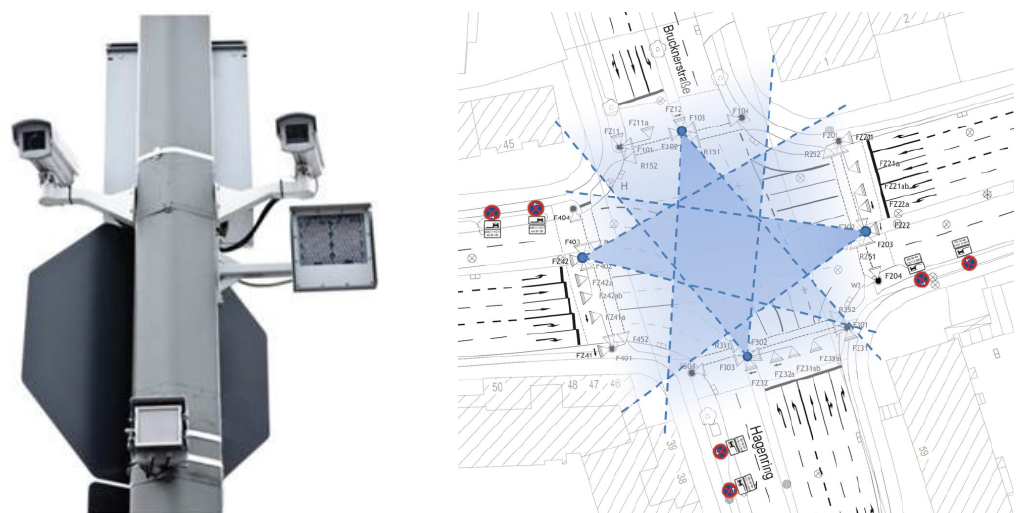
Figure 2: Single pole installation of MSS (left) and bird’s eye view of all sensor locations (right) In addition, SENV is installed on the Western and Southern pedestrian crossing. There are four installa- tions which are respectively attached on the opposite sides of the crossings. Each of these installations consists of a stereo camera system and an infrared lighting unit.